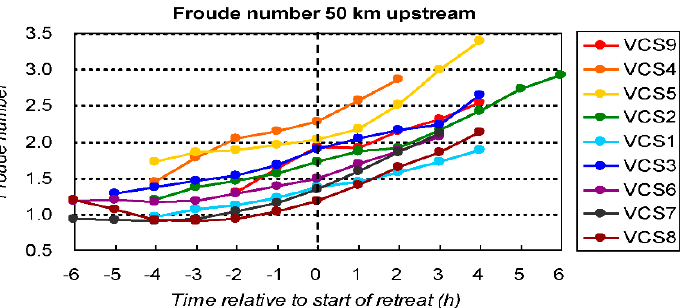
Figure 14. Temporal evolution of Fr (below 2.5 km) at 50 km upstream from the rainband on the nine VCSs (VCS1-VCS9), from 6 h before to 6 h after the beginning of retreat. The time of retreat commencement in all VCSs (cf. Table 2) is placed at the origin along the abscissa.